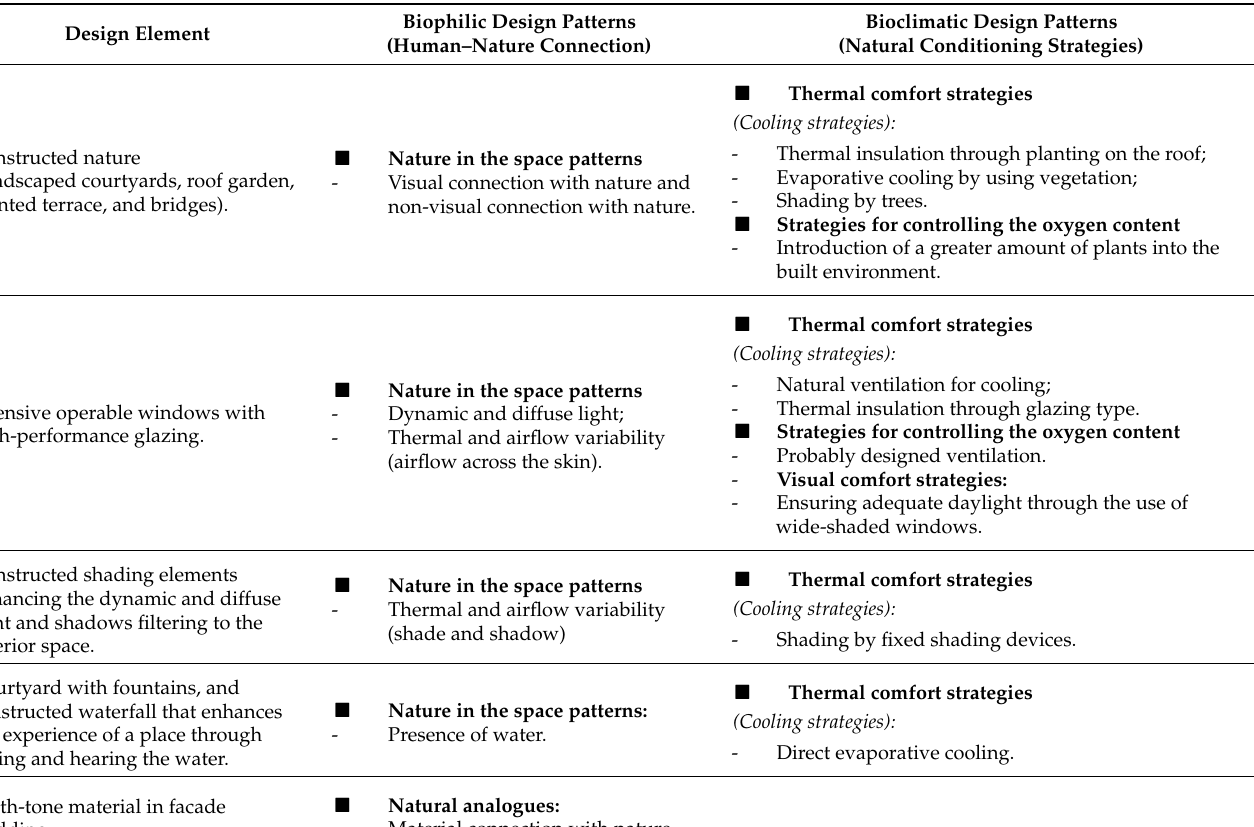
Table 5. The bioclimatic and biophilic design strategies and patterns of Optima Camelview Hous- ing